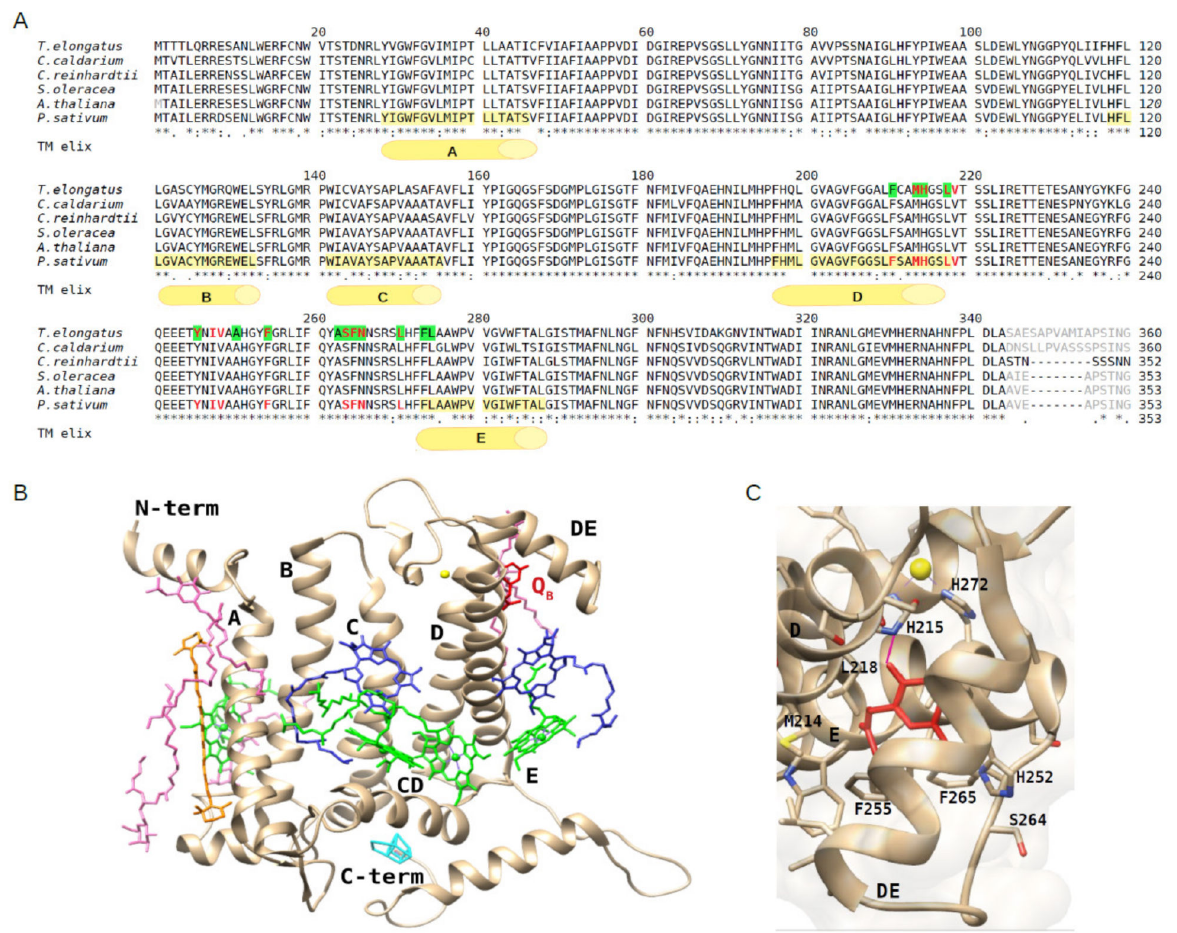
Figure 1. Alignment of the D1 protein sequences retrieved from high-resolution structures (chain A of each PDB entry) of representatives of cyanobacteria, algae and plants and view of the D1 protein structure and the Q B binding site of P. sativum . ( A ) Alignment of D1 sequences from the red alga Cyanidium caldarium (UniProtKB O19895, PDB: 4YUU at 2.7 Å), green alga Chlamydomonas reinhardtii (UniProtKB P07753, PDB: 6KAC at 2.7 Å) and higher plants Spinacia oleracea (UniProtKB P69560, PDB: 3JCU at 3.2 Å), Arabidopsis thaliana (UniProtKB P83755, PDB: 5MDX at 5.3 Å) and Pisum sativum (UniProtKB P06585, PDB: 5XNL, at 2.7 Å) along with that from the cyanobacterium Termosynechococcus elongatus (UniProtKB P0A444, PDB: 4V82, at 3.2 Å). In the latter, the amino acids of the Q B niche involved in the terbutryn binding are highlighted in green. Amino acids surrounding the plastoquinone Q B head are colored in red in the sequences from T. elongatus and P. sativum . Amino acids not resolved in the structures are indicated in grey. The five transmembrane α -helices of the D1 protein of P. sativum , indicated by letters A–E, are highlighted in yellow in the corresponding sequence. ( B ) View of the D1 protein and cofactors from the structure of P. sativum (PDB: 5XNL, chain A). Plastoquinone Q B in red, non-heme Fe in yellow, Chls in green, Pheo molecules in blue, β -carotene in orange, lipids in pink, oxygen evolving complex (OEC) in cyan. ( C ) View of the Q B binding site within the D1 protein rotated with respect to the view in panel B to better show the plastoquinone head (in red), the surrounding amino acid residues and the hydrogen bond (indicated as purple